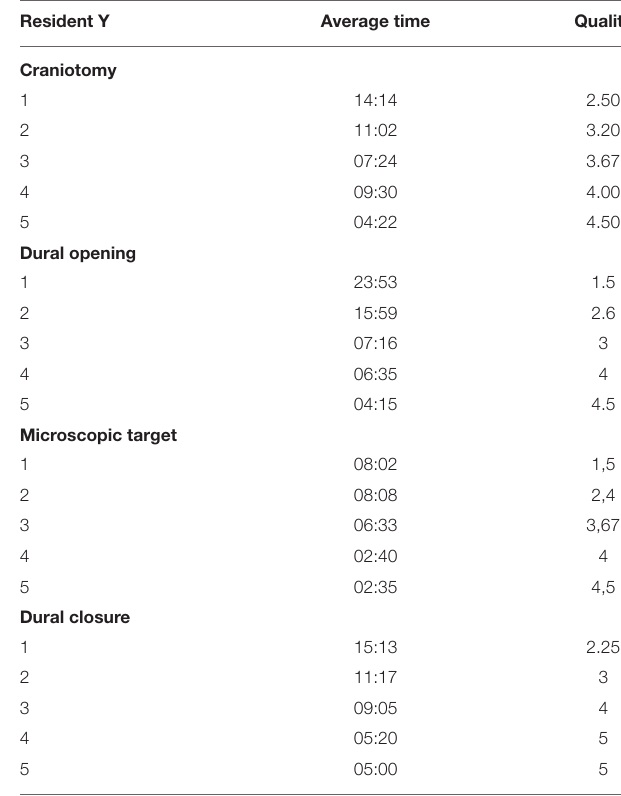
TABLE 4 | Descriptive results stratified by year of